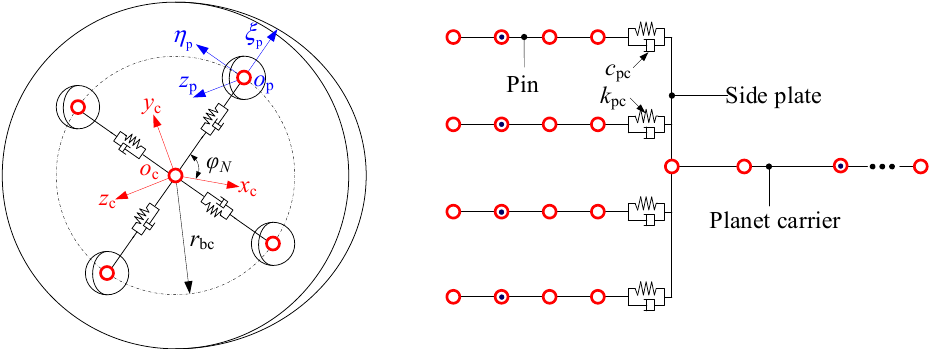
Figure 8. Meshing relationship of the PGT.